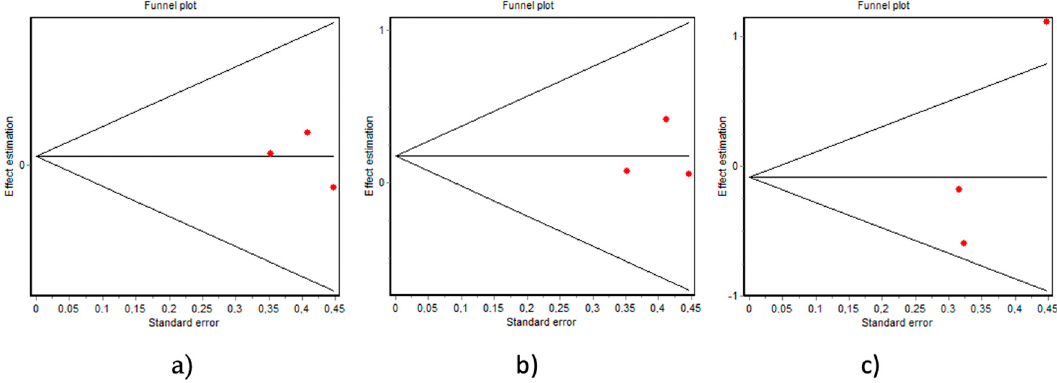
Figure 7. Funnel plot to show the risk of bias in the analyzed study: ( a ) CAL gain in Er:YAG laser group ( p = 1.0000), ( b ) PPD reduction in Er:YAG laser group ( p = 1.0000) and ( c ) PPD reduction in diode laser group ( p = 1.0000).